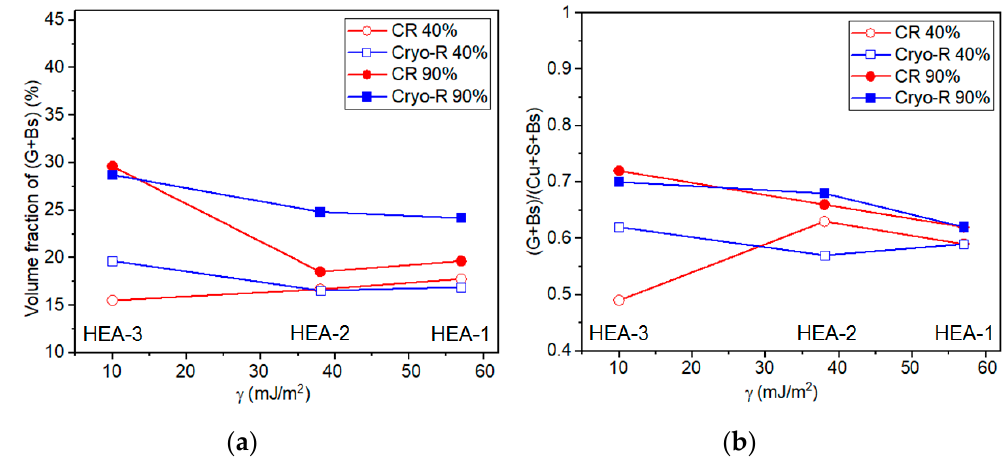
Figure 8. (a) Volume fraction of the α -fiber components (G + Bs) and (b) the ratio of the volume fractions of the α -fiber (G + Bs) and β -fiber components (Cu + S + Bs) as a function of the stacking fault energy γ .